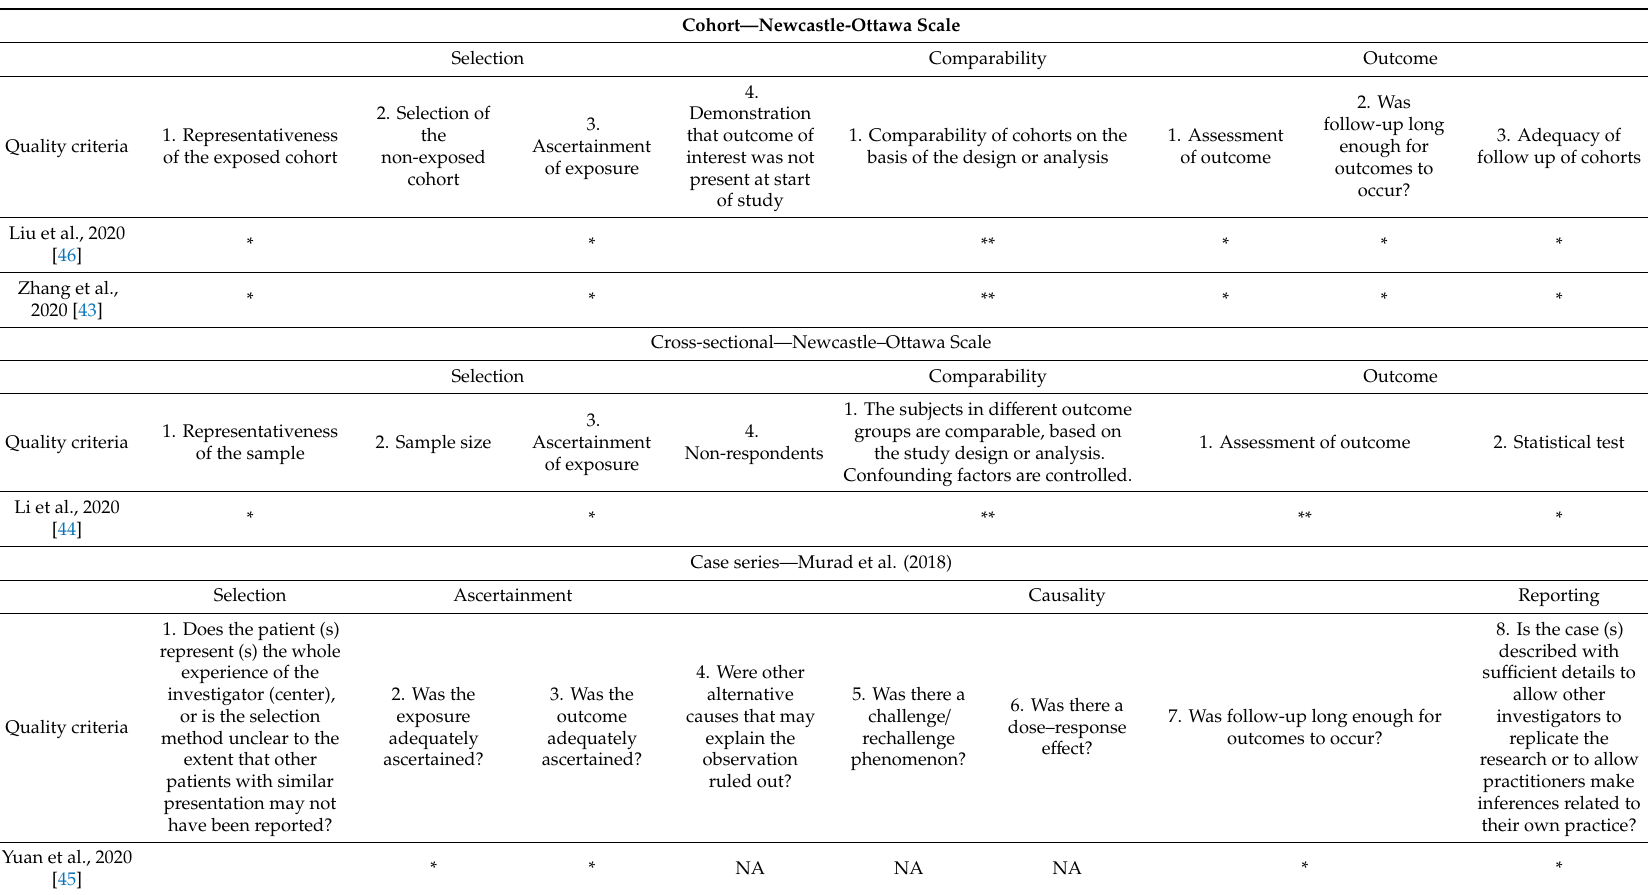
Table 1. Methodological quality of included studies ( n =